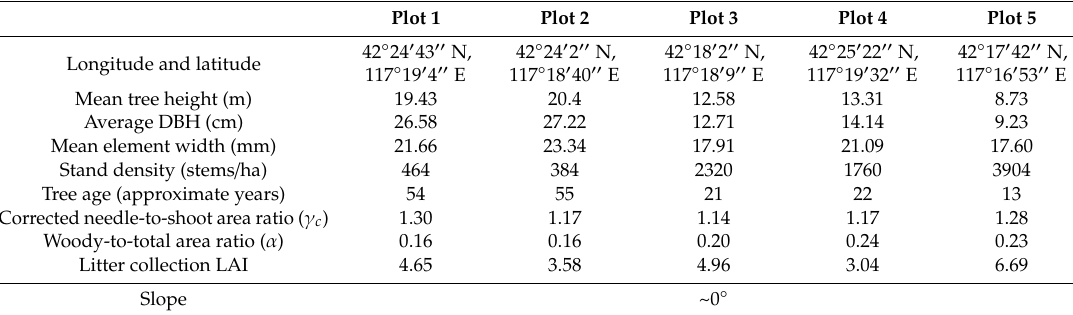
Table 3. Characteristics of the L. principis-rupprechtii plots [23]. Plot 1 Plot 2 Plot 3 Plot 4 Plot